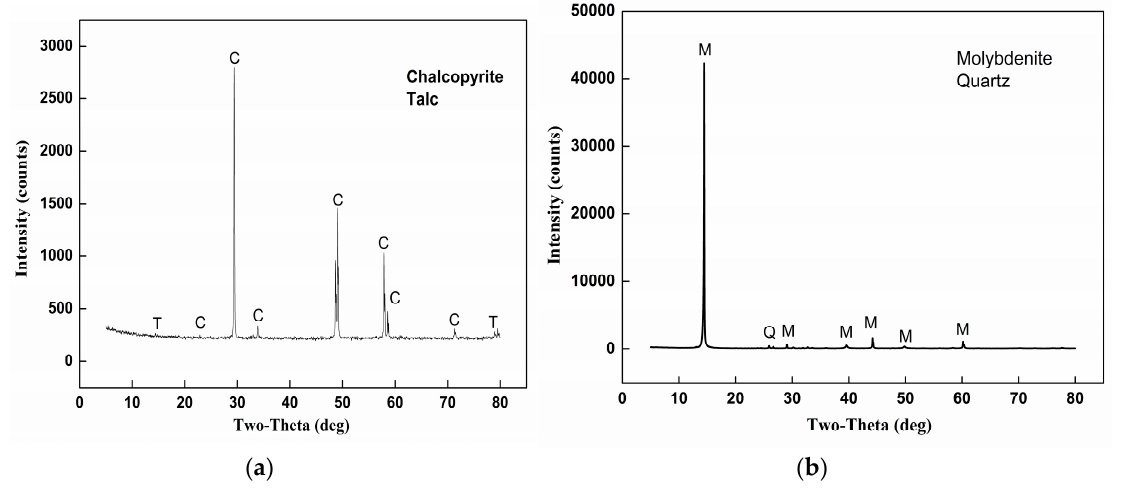
Figure 2. XRD spectra of pure ( a ) chalcopyrite and ( b ) molybdenite for flotation tests.